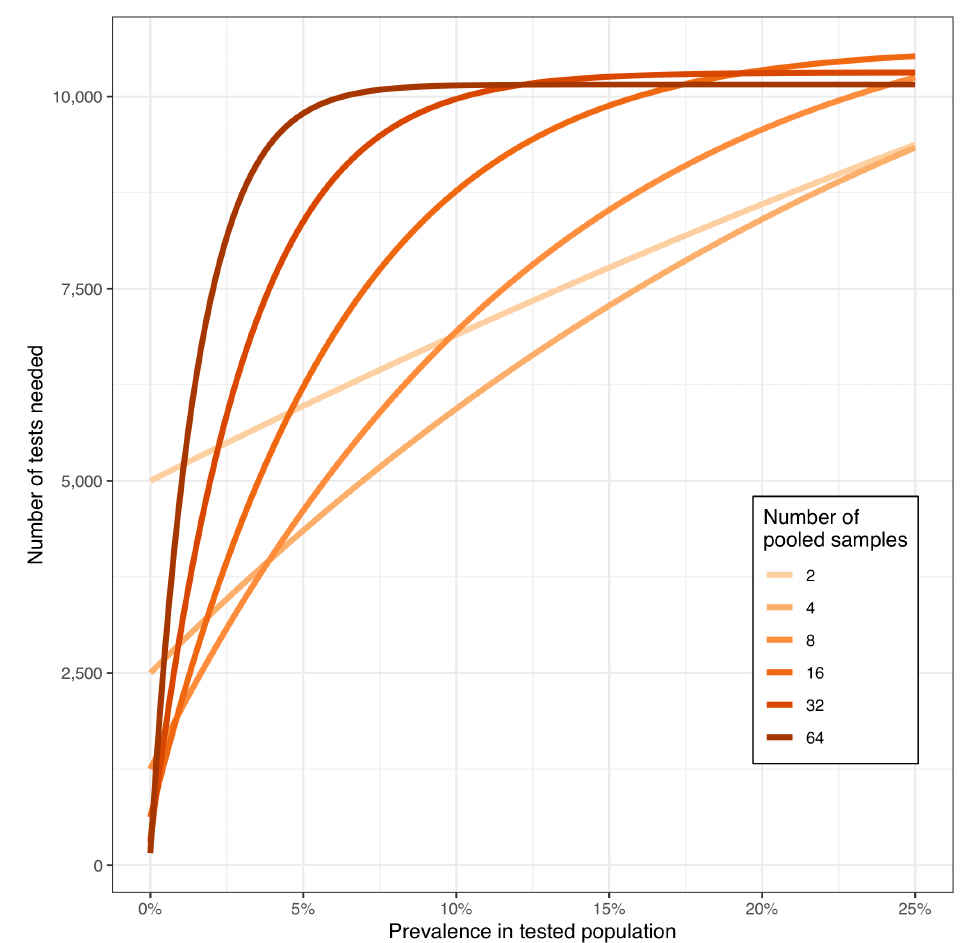
Figure 1. Number of PCR tests required as a function of pool size at different prevalences in a hypothetical population of 10,000 individuals.